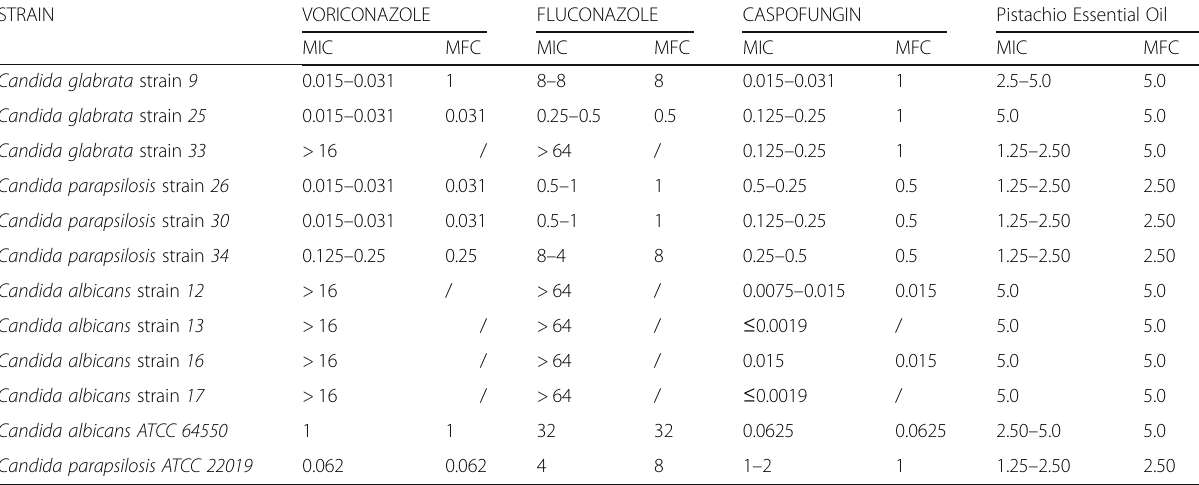
Table 2 MICs and MFCs of Pistachio Essential Oil (expressed as mg/ml) and antifungal compounds (expressed as µg/ml) against Candida sp